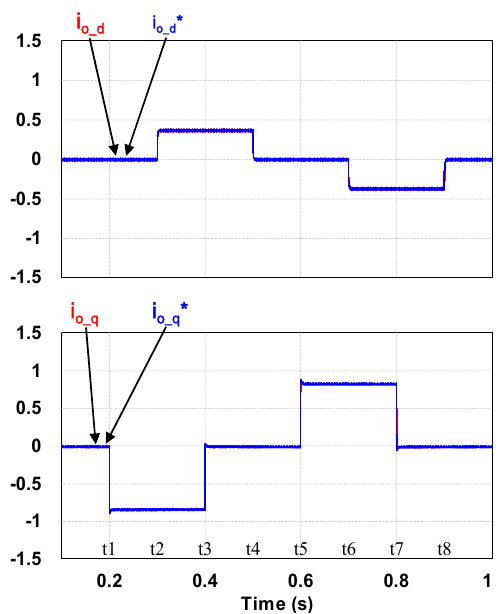
Figure 28. Waveforms of control commands and feedbacks: qd-axis inductor currents.